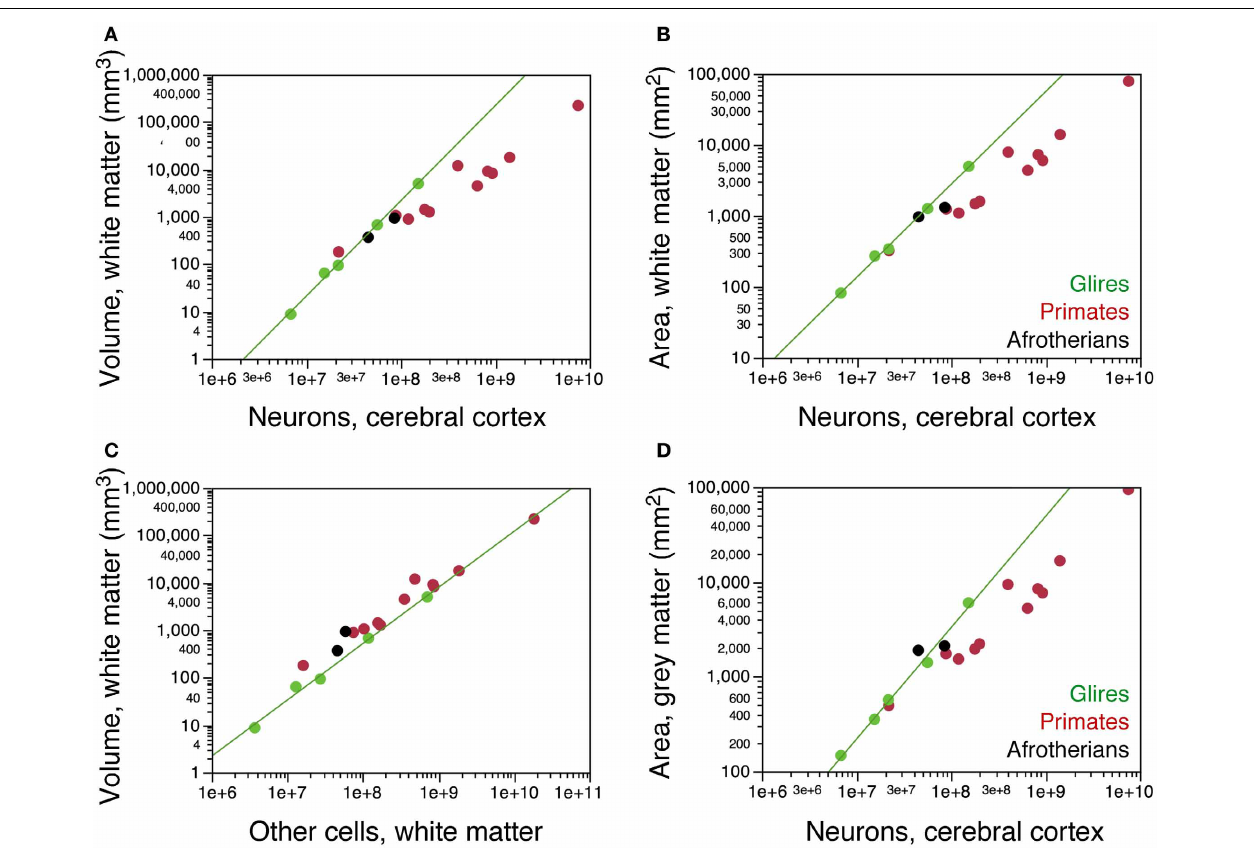
FIGURE 7 | Scaling of the subcortical white matter. (A) Variation in the volume of the subcortical white matter as a function of numbers of neurons in the cerebral cortex in the two hyrax species (afrotherians, black), rodents (green) and primates (red). The hyraxes overlap with the power function that applies to rodents (exponent, 2.009 ± 0.065). (B) Variation in the surface area of the subcortical white matter (that is, the surface of the gray-white matter interface) as a function of numbers of neurons in the cerebral cortex. The hyraxes overlap with the power function that applies to rodents (exponent, 1.308 ± 0.038). (C) Variation in the volume of the subcortical white matter as